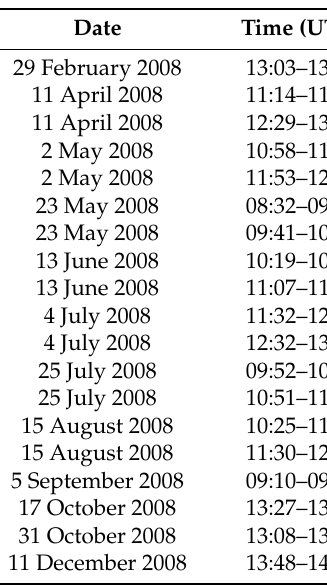
Table 1. Summary of the whole flights during the 2008 in the west of the Netherlands (Figure 1). Including measurement date, time (coordinated universal time, UTC), flight height (above ground level, m), and Monin–Obukhov (M–O) stability parameter ζ